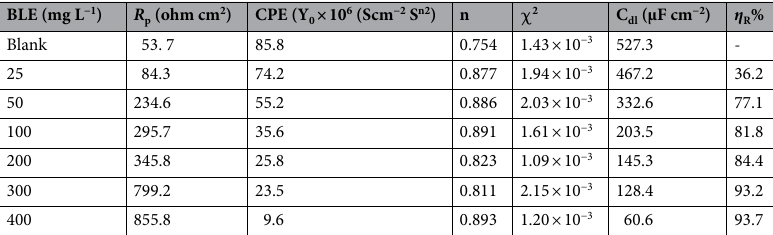
Table 3. Percentage corrosion inhibition efficiency and EIS parameters of varied concentrations of BLE extract for X52-steel in 1.0 M HCl at 298 K calculated by EIS method.